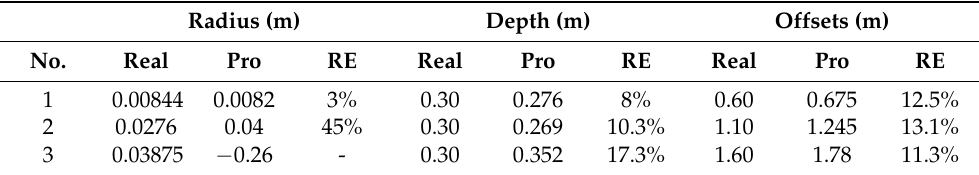
Table 4. Radius and location estimation of the root in the controlled experiment. Radius (m) Depth (m) Offsets